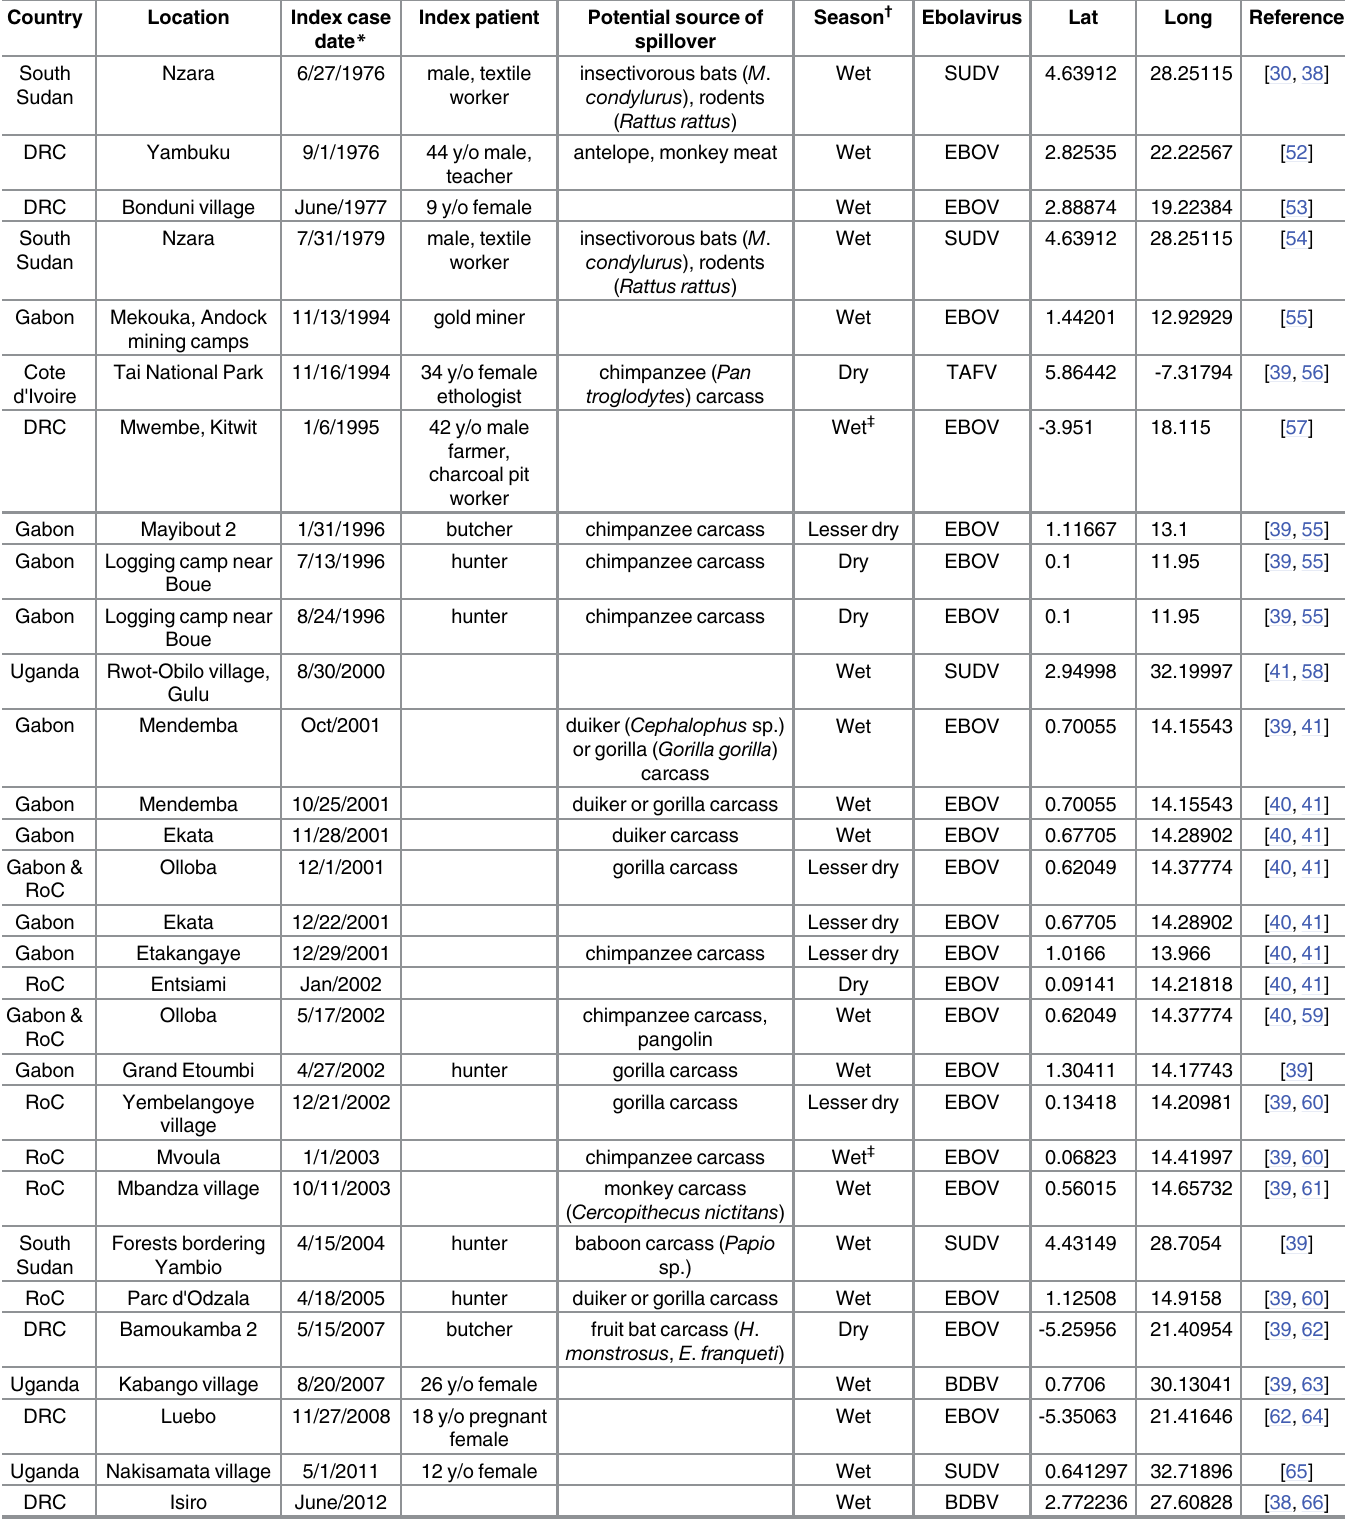
Table 1. Ebolavirus index cases and associated spillover events 1976 –